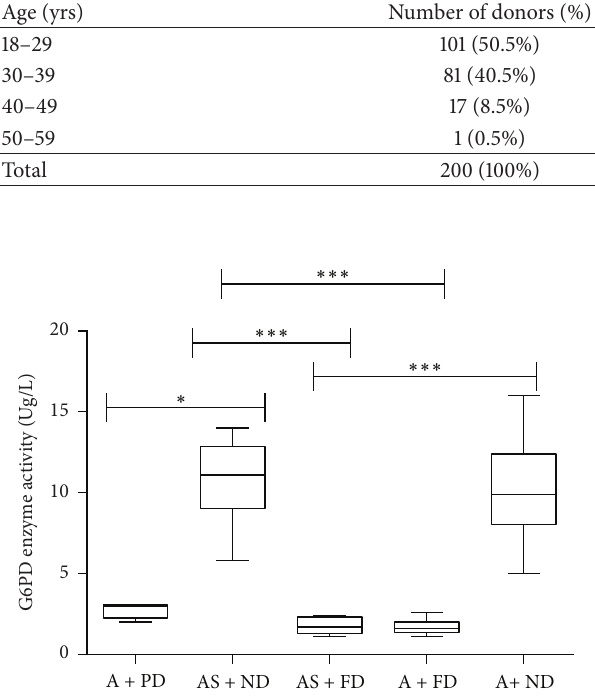
Figure 2: Comparison of red blood cell G6PD enzyme activity levels of blood donors. G6PD activities of red cells were measured using quantitative G6PD kit from Trinity Biotech and calculated againstthedonorhaemoglobinlevels.Statisticaldifferencesbetween G6PD enzyme activities were estimated using Kruskal-Wallis test with Dunn’s posttest for multiple comparisons. A: haemoglobin A; S: haemoglobin S; ND: no qualitative G6PD activity; FD: full